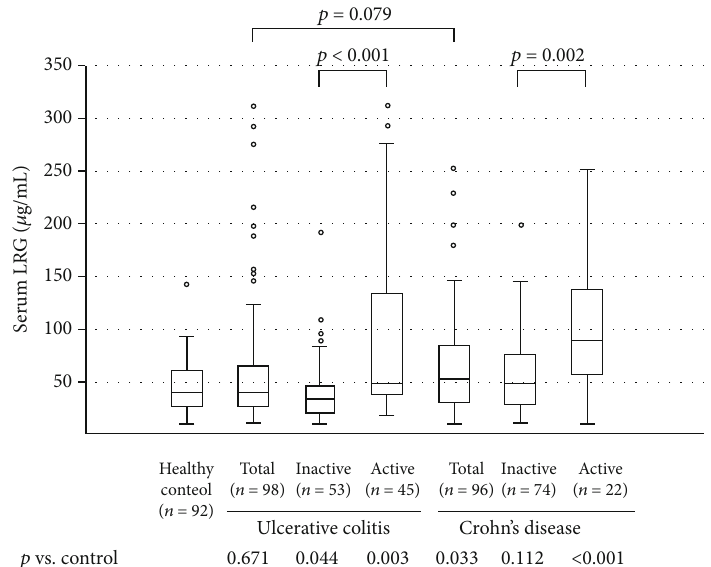
Figure 1: Serum levels of leucine-rich alpha-2 glycoprotein (LRG) in patients with ulcerative colitis, patients with Crohn ’ s disease, and healthy control individuals. The bars indicate the median ± 25 th percentile. The lower bar indicates the 10 th percentile, and the upper bar indicates the 90 th percentile.